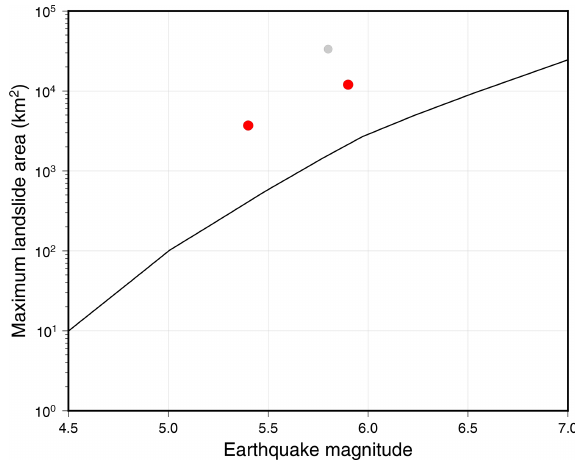
Figure 8. Maximum landslide area for earthquakes in intraplate ar- eas. Red dots: Norway (this study); grey dot: 2011 Virginia, USA, earthquake (Jibson and Harp, 2012); black curve: maximum land- slide area limit from Rodriguez et al.